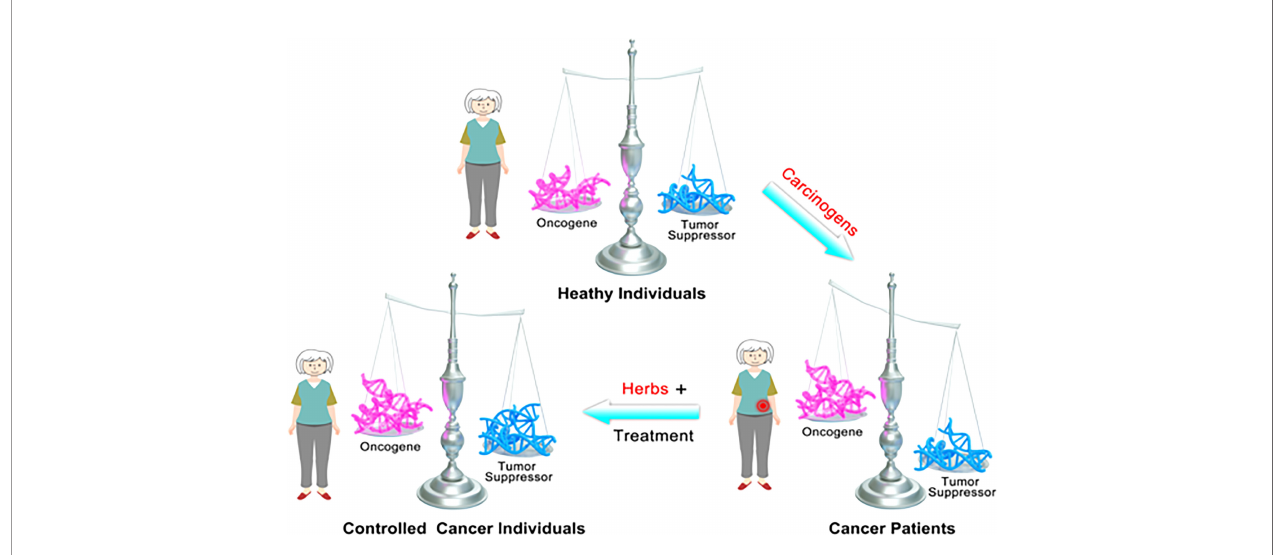
FIGURE 6 | Schematic diagram shows the mechanism underlying long-term use of b -elemene in cancer treatment or cancer